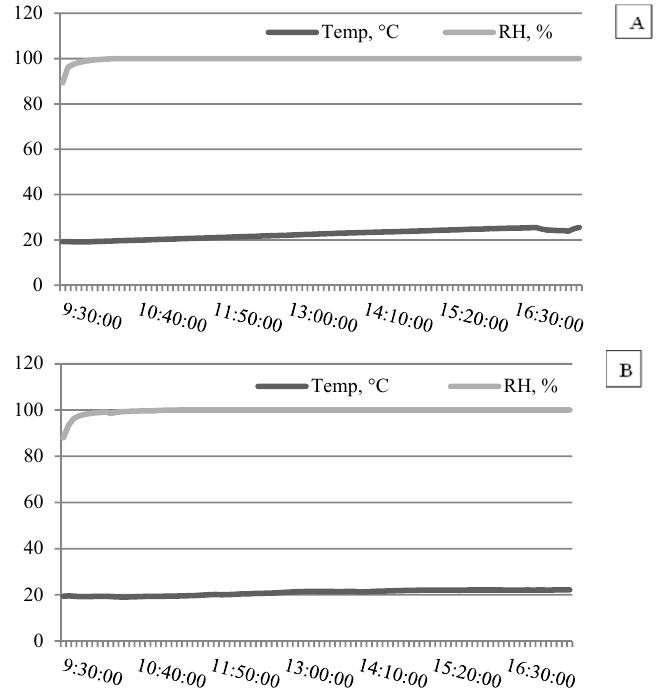
Figure 5. Internal air temperature and relative humidity within clamshell package #3 stored in the same location within a covered ( A ) and uncovered ( B ) pallet on 25 February 2014.